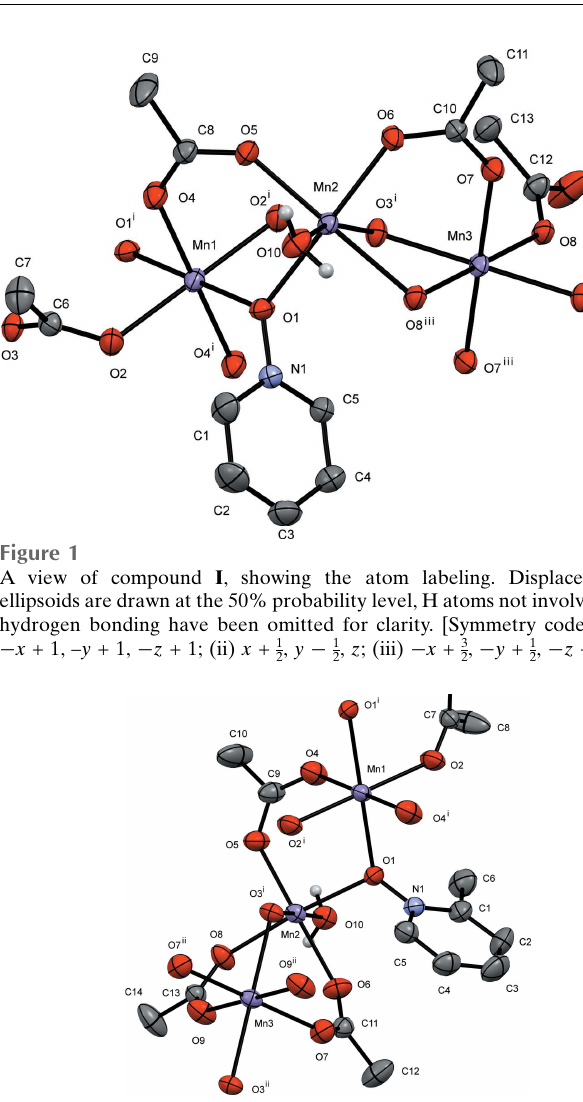
Figure 2 A view of compound II , showing the atom labeling. Displacement ellipsoids are drawn at the 50% probability level, H atoms not involved in hydrogen bonding have been omitted for clarity. [Symmetry codes: (i) (cid:4) x + 1, (cid:4) y + 1, (cid:4) z + 1; (ii) (cid:4) x + 1, (cid:4) y , (cid:4) z +